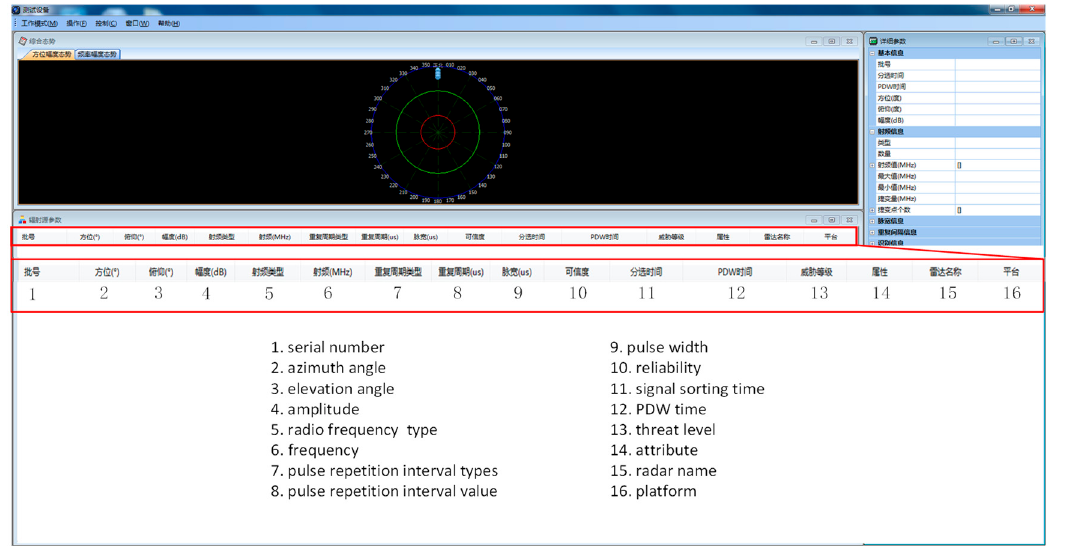
Figure 12. Signal sorting experiment equipment connection diagram.